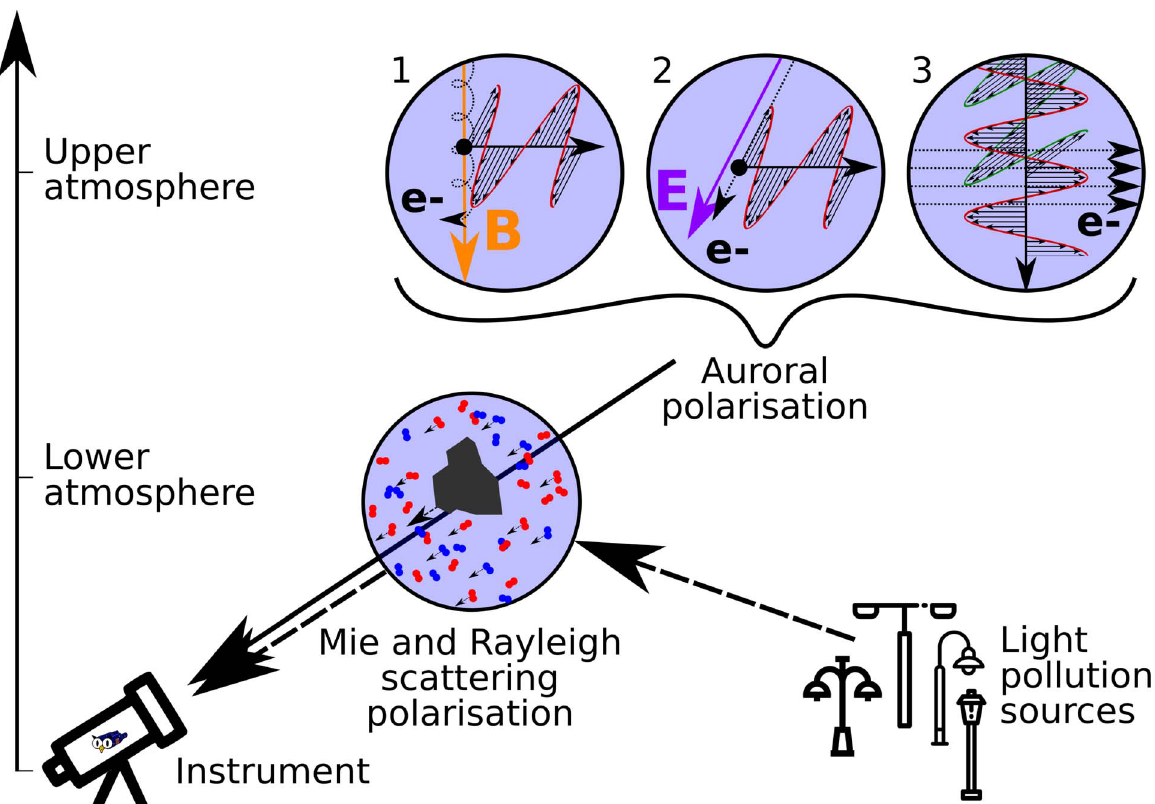
Fig. 1. Representation of the main physical processes at play in the following article. The instrument (lower left corner) observes two main light sources: the aurora (solid black arrows) and the scattering of another source of light in the lower atmosphere (dashed black arrows). The latter is represented by the center circle representing Mie and Rayleigh scattering on aerosol and air molecules. Its origin is shown here as street lamps but could be due to other sources like snow re fl ection or aurorae. The auroral polarisation model is uncertain at this point and could follow any of the three models represented in the top right numbered 1, 2, and 3. In those, the electron ’ s motion direction is the thin dotted lines, in 1, the magnetic fi eld is the orange line (B), and in 2, the electric fi eld is the purple line (E). Auroral emission is the thin black line with a polarisation direction represented by the red and green